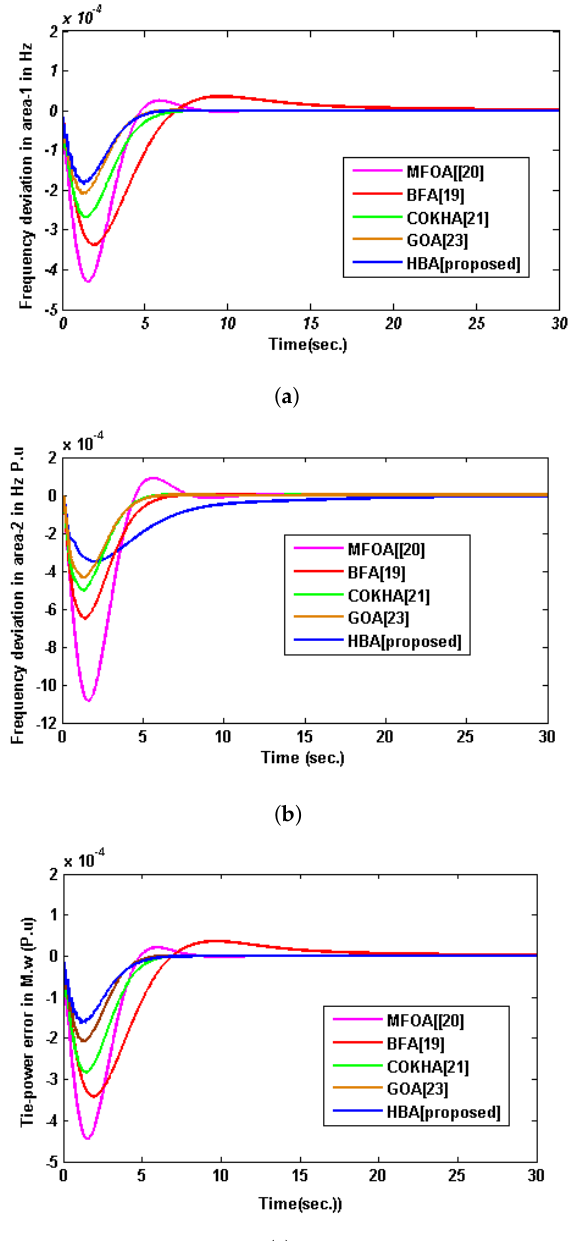
Figure 4. ( a ) Frequency deviation in area 1 in Hz p . u . ( b ) Frequency deviation in area 2 in Hz p . u . ( c ) Tie − power error in MW in p . u . (BFA [19], MFOA [20], COKHA [21], and GOA